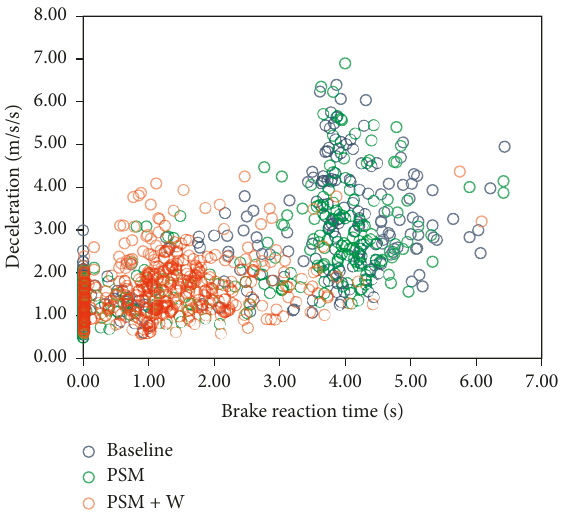
Figure 17: Brake reaction time and deceleration under different crossing